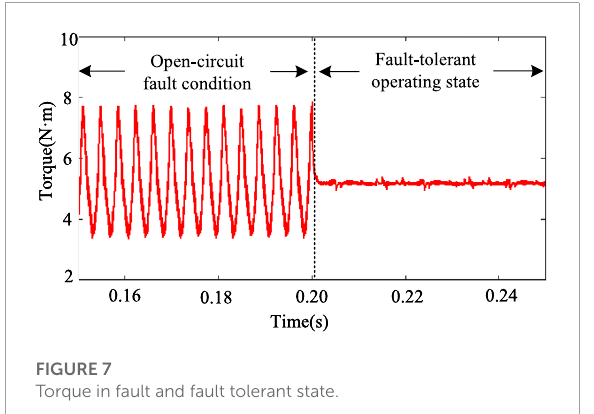
FIGURE 7 Torque in fault and fault tolerant state.